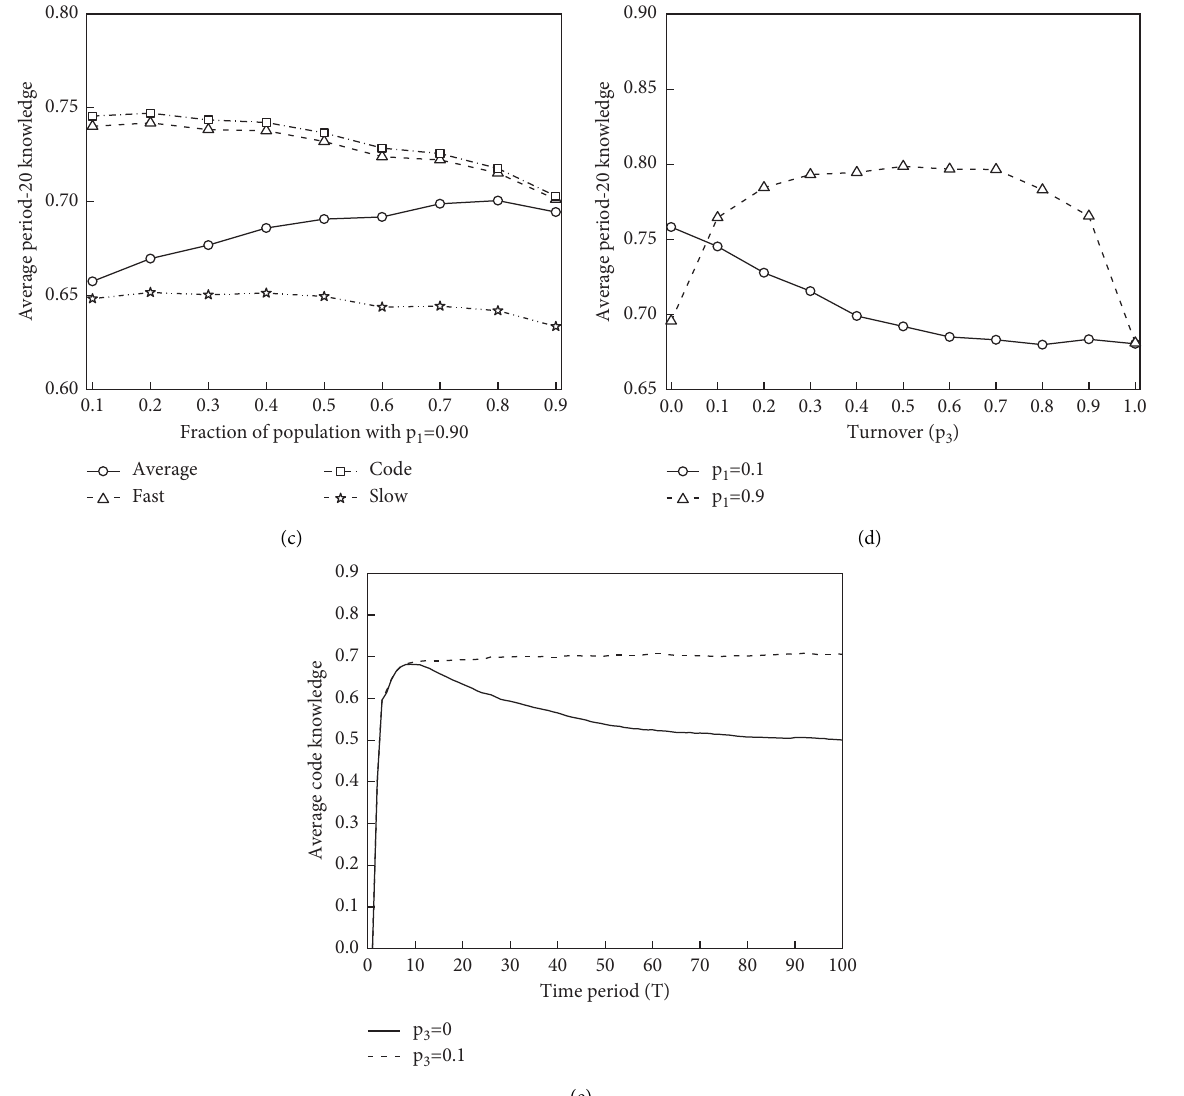
Figure 2: Results of replication. (a) Effect of learning rates ( p 1 , p 2 ) on equilibrium knowledge. (b) Effect of heterogeneous socialization rates ( p 1 � 0.1, 0.9) on equilibrium knowledge. (c) Effect of heterogeneous socialization rates ( p 1 � 0.1, 0.9) on period-20 knowledge. (d) Effect of turnover ( p 3 ) and socialization rate ( p 1 ) on period-20 code knowledge. (e) Effect of turbulence ( p 4 ) on code knowledge over time, with and without turnover ( p 3